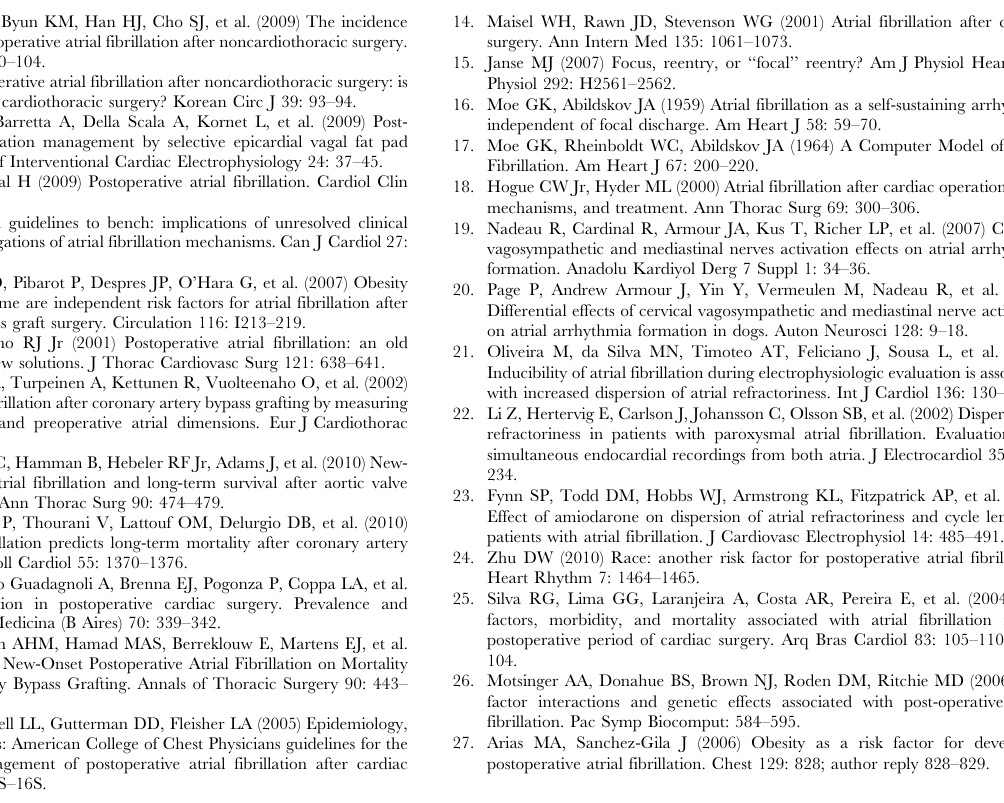
Table S1 p-value from univariate and multivariate logistic regression model with position data and 5 min- utes partition. Table S2 Relation of the preoperative risk with the evolutionary scores. Pearson correlation of the preoperative risk, with the score of last interval (I), the mean score of all intervals (II), and the difference the score of the last interval and the mean of other intervals (III) for time partitions of 5, 10, 20, 30, 60 minutes. The values in parentheses are the two tailed significance